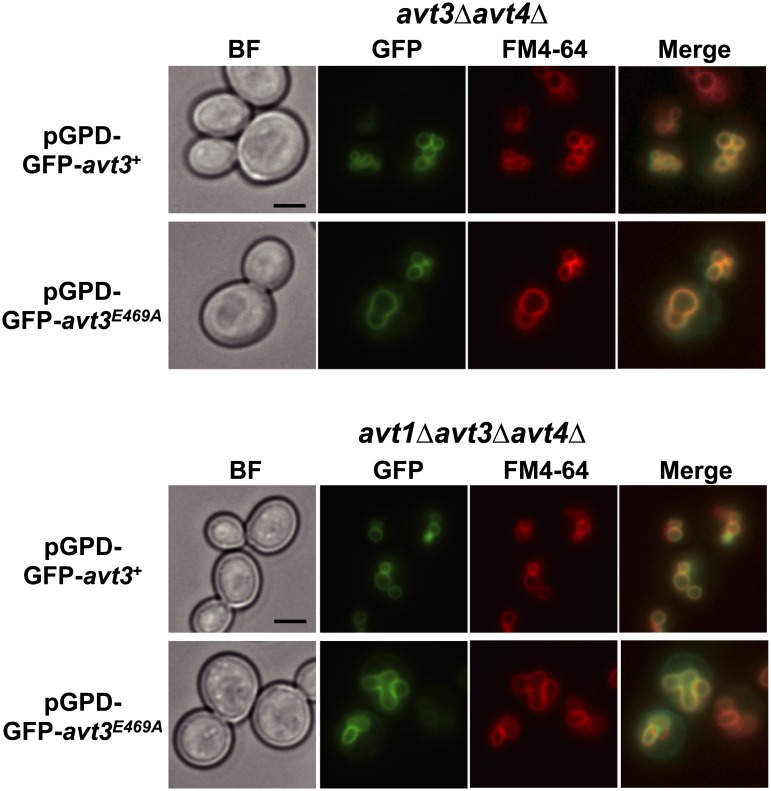
Intracellular localization of SpAvt3p in S. cerevisiae cells.The avt3Δavt4Δ or avt1Δavt3Δavt4Δ mutant cells expressing GFP-SpAvt3p or GFP-SpAvt3pE469A fusion protein were subjected to fluorescence microscopy. Vacuolar membranes were labeled with FM4-64. BF, bright field; bar, 3 μm.